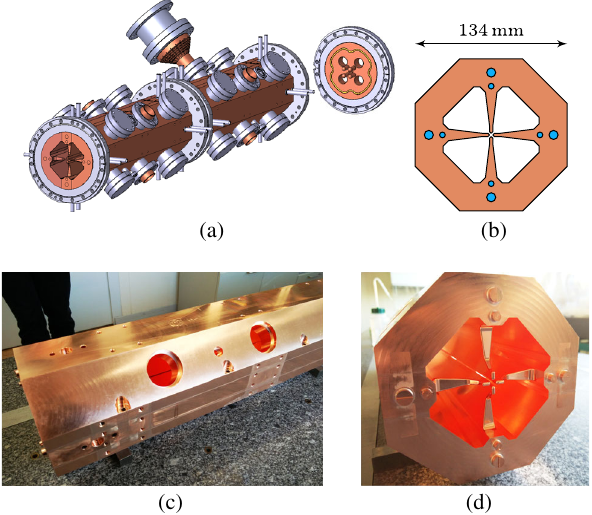
FIG. 1. CAD model of the PIXE RFQ linac with equipped tuners, pumping ports, coupler, and detached end plates with dipole stabilization rods (a) and cavity cross section with water cooling channels (b). Figures (c) and (d) show different views of the first module after the initial